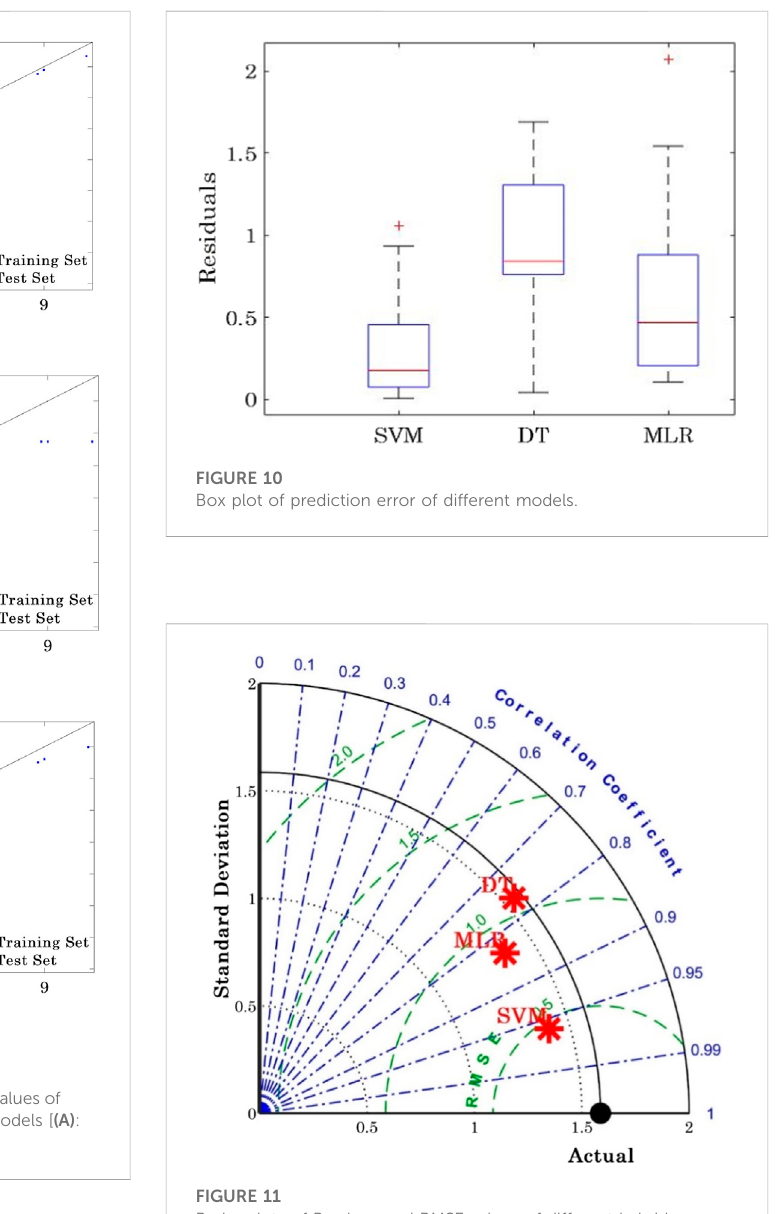
FIGURE 11 Radar plots of R values and RMSE values of different hybrid machine learning